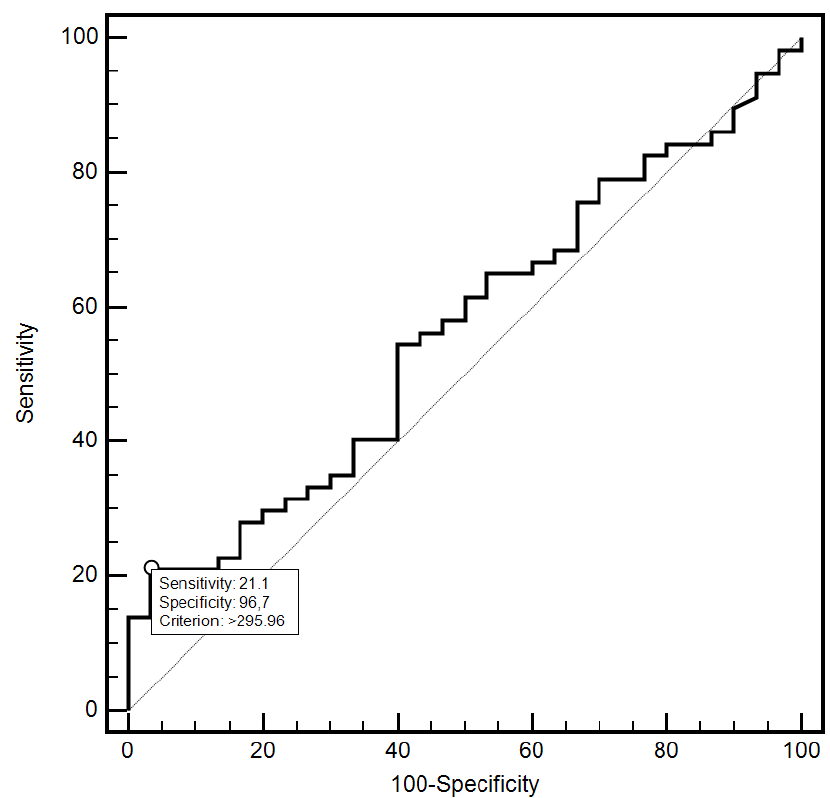
13 Figure 13. Evaluation of the diagnostic usefulness of MMP-9 (ng/mL) concentration determination in samples taken from the cervix in the early detection of preterm labor using the ROC curve. Table 4. Characteristics of the parameters of ROC curves for the concentration values of MMP-8 cervical (ng/mL). Parameter AUC SE 95%CI Age (years) 0.550 Cervical length